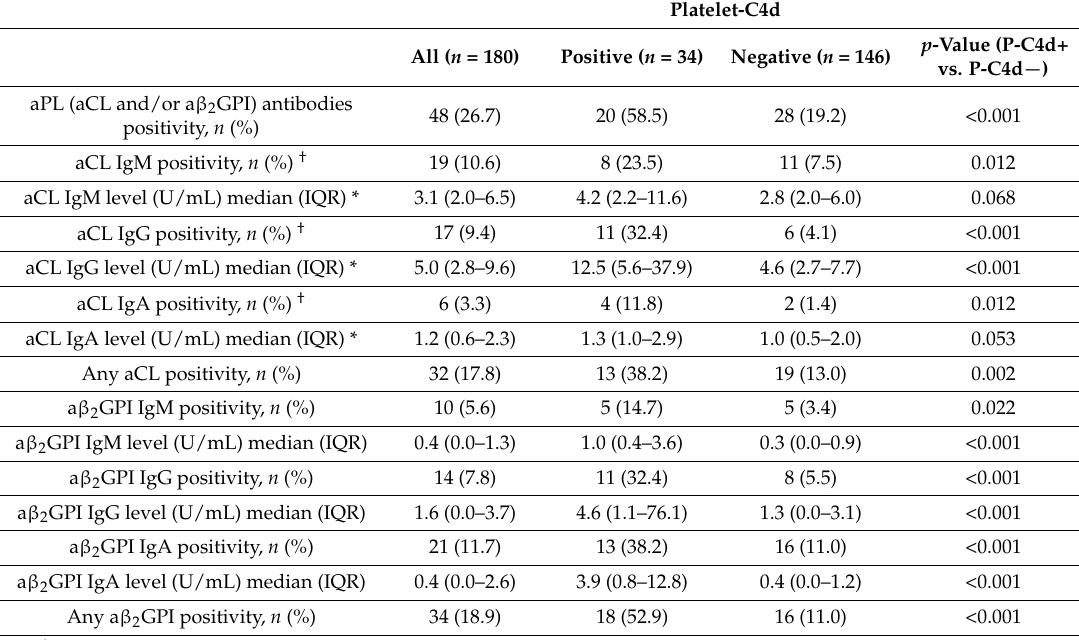
Table 2. Comparison of serum anti-Cardiolipin (aCL) and anti- β 2 GPI (a β 2 GPI) levels in P-C4d-positive vs. P-C4d-negative